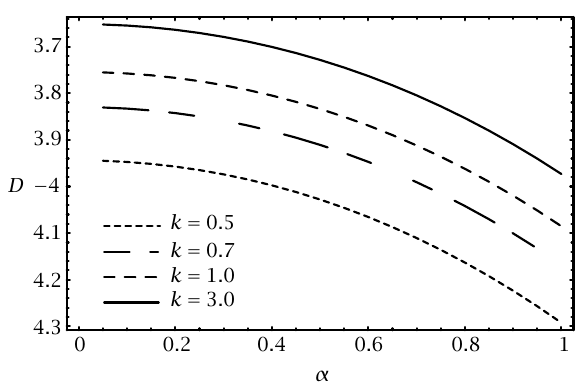
Figure 6.1 . Variation of D with wave number α and permeability parameter k at Re = 1 . 0.